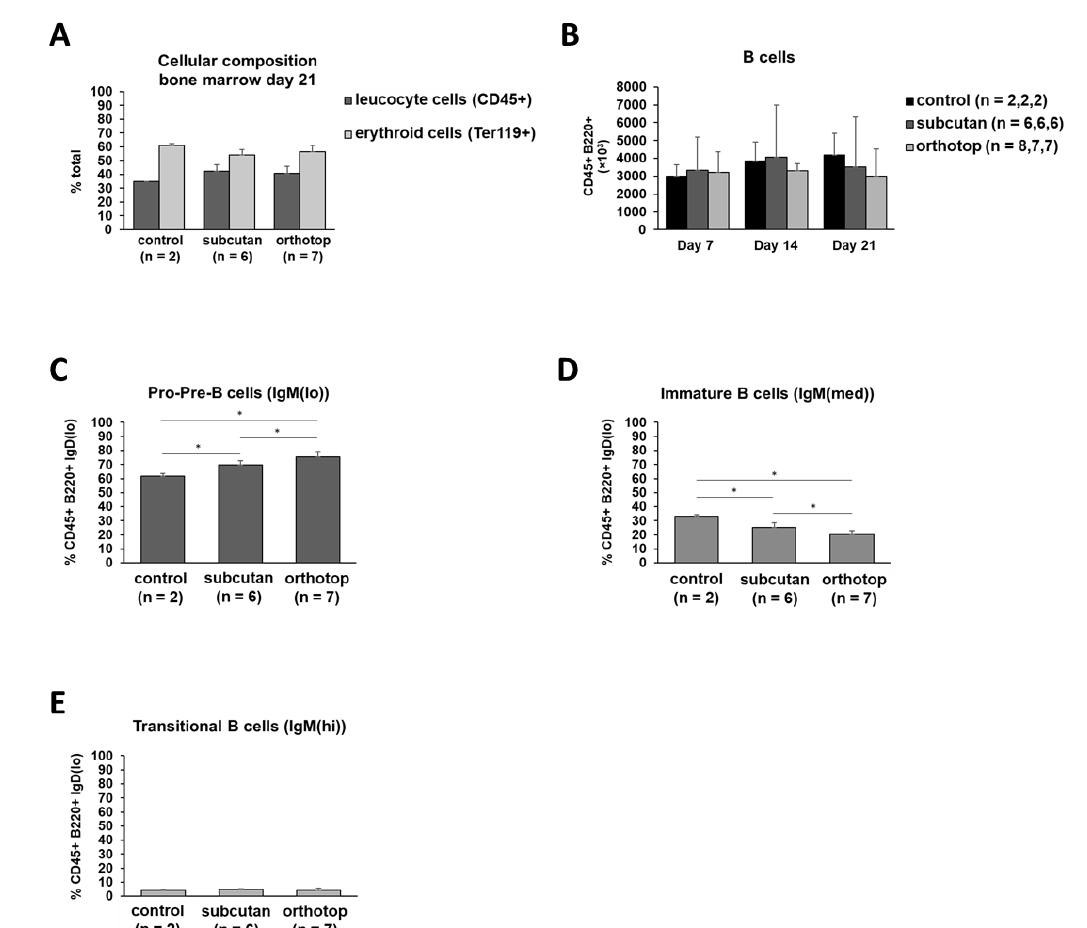
Figure 8. Cellular composition and B cell characterization in the bone marrow of orthotopic and subcutaneous HNSCC- bearing mice. ( A ) Cells of the bone marrow were harvested and divided into the erythroid and lymphoid cell lineage using flow cytometry. ( B ) B cells in the bone marrow on day 7, day 14, and day 21 after tumor induction are compared to healthy control mice. ( C – E ) Early B cell forms (IgD(lo)) are characterized by IgM expression intensity. On day 7, day 14, and day 21 the test group size for the subcutaneous group is n = 6, while for the control group n = 2. The test group size for the orthotopic group on day 7 is n = 8, day 14 n = 7, and day 21 n = 7. p -values < 0.05 were considered to be significant with (*). Data shown here are listed in Table S5.